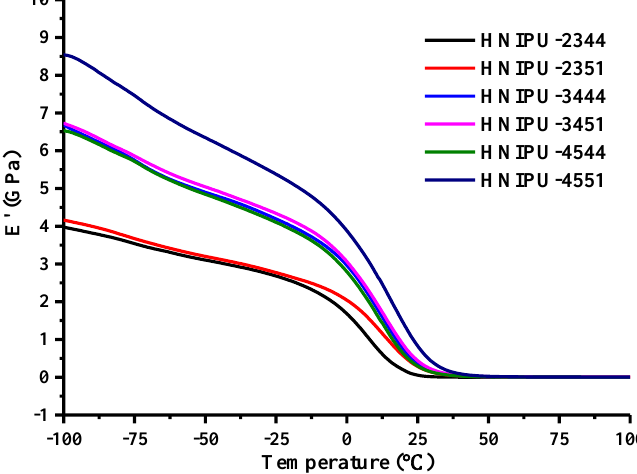
Figure 5. Storage modulus (E′) as a function of temperature for different HNIPUs.